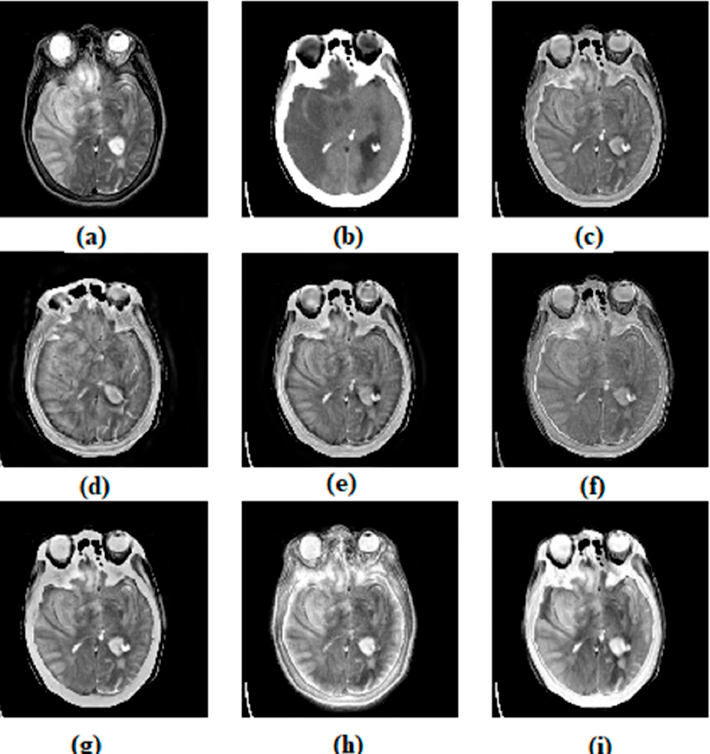
Figure 6. Visual quality analysis of various fusion algorithms for MRI-CT (set-11). ( a ) MRI image, ( b ) CT image, ( c ) ASR, ( d ) CVT, ( e ) DTCWT, ( f ) MSVD, ( g ) CSMCA, ( h ) NSST, ( i ) proposed meth- od.